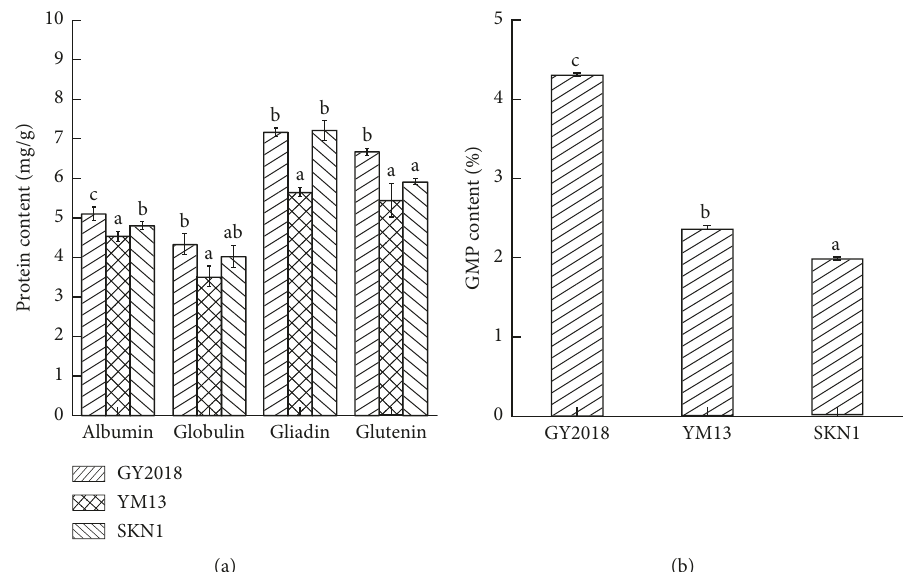
Figure 3: Analysis of Osborne protein fractions content (a) and GMP content (b) in GY2018, YM13, and SKN1. Different lowercase letters indicated that there were significant differences between the same Osborne fractionation with other varieties ( p < 0 . 05) (a); different letters represent significant differences between the different varieties ( p < 0 . 05)